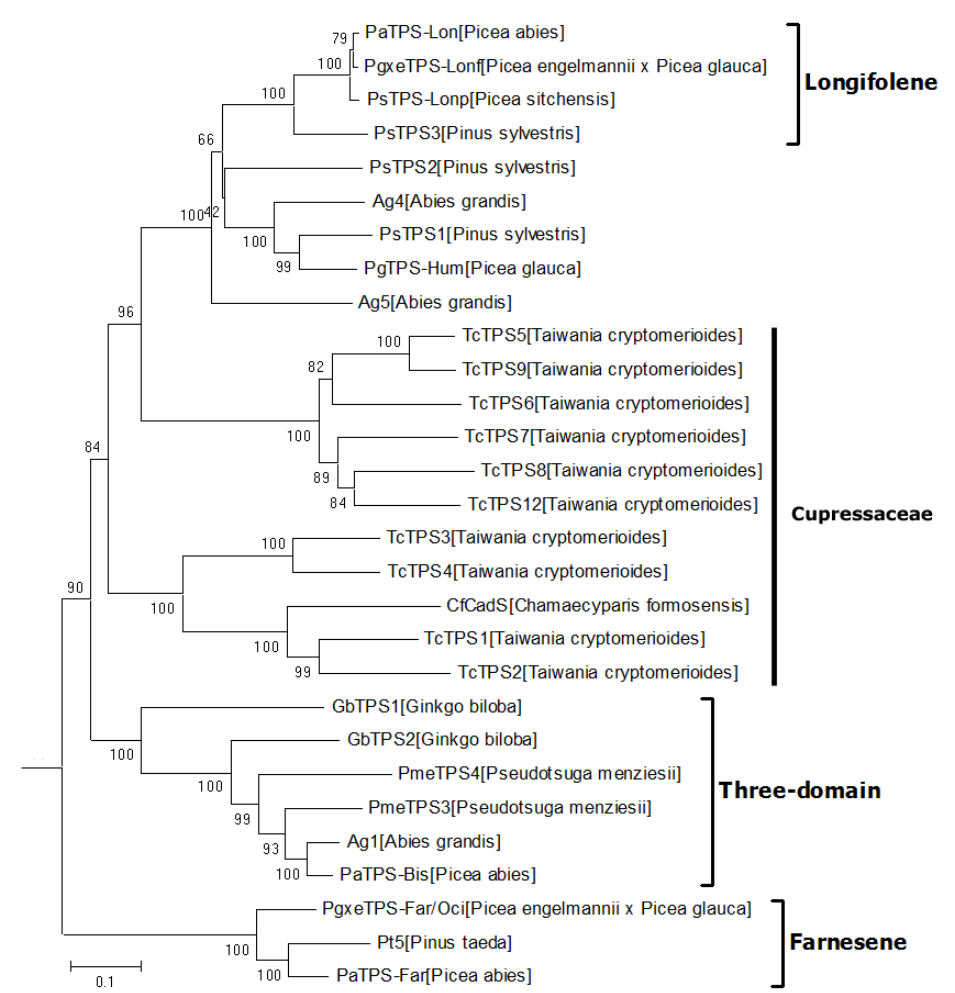
Figure 5. The phylogeny of spermatophyte STSs in the TPS-d subfamily.